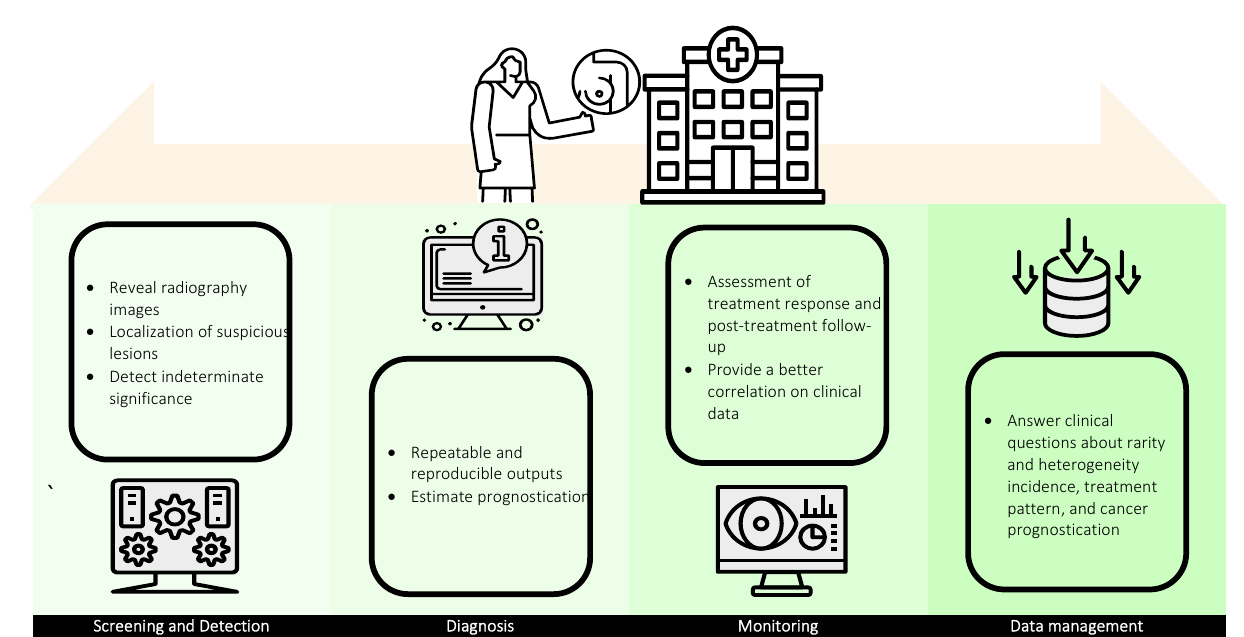
Figure 3. Utility of AI in breast imaging: screening and detection, diagnosis, monitoring, and data management.